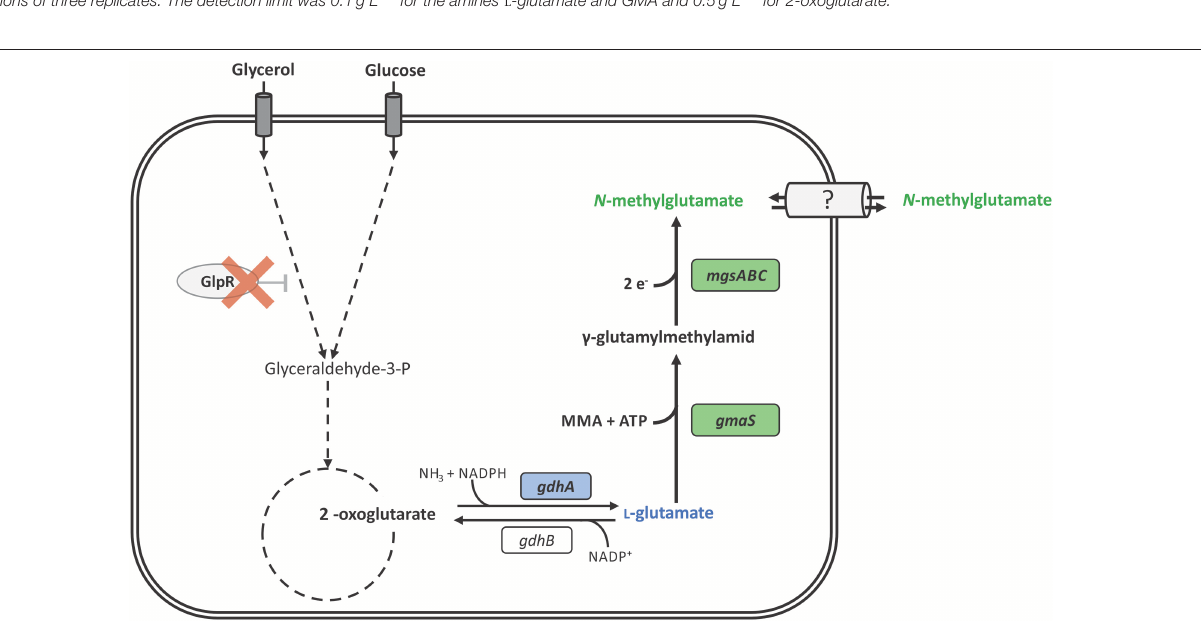
FIGURE 1 | Schematic overview of the reaction catalyzed by γ -glutamylmethylamide synthetase (GMAS) and N -methylglutamate synthase (NMGS) and their incorporation in the metabolism of P. putida KT2440. N -methylglutamate formation (thick arrows) takes place by heterologous expression of gmaS and mgsABC from M. extorquens DM4 (green boxes) starting from L -glutamate. Deletion of the transcriptional repressor gene of the glycerol metabolism ( glpR ) is indicated by red cross. The second copy of endogenous glutamate dehydrogenase ( gdhA ) under control of Ptac was integrated in glpR locus (blue boxes). Reactions are indicated by an arrow, multiple reactions by dashed